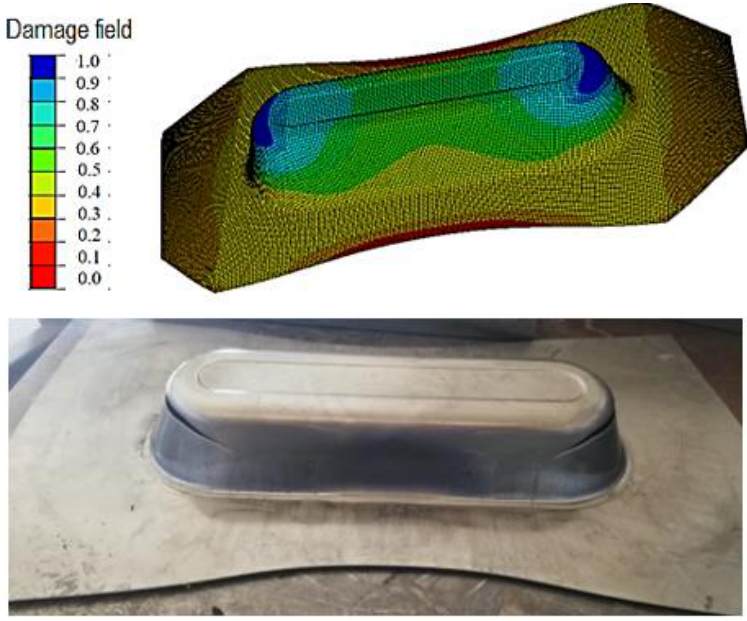
Figure 8. Second test: Experimental and Numerical results of car fuel tank deep drawing.